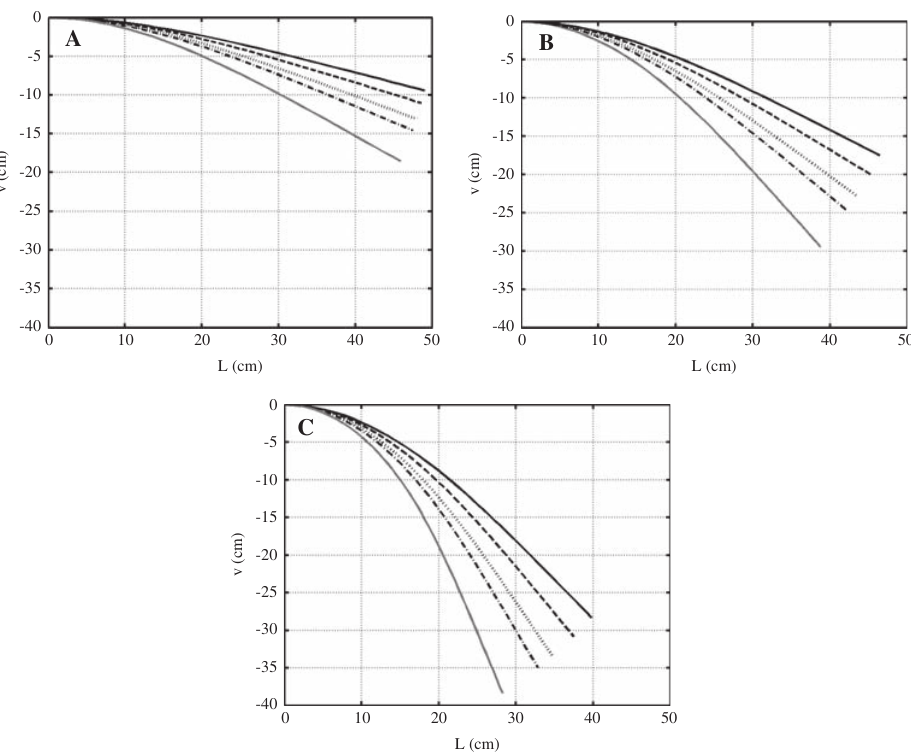
Figure 7 Defl ected shape of the beam for various values of the power-law exponent for (A) q = 125 N/cm 2 , (B) q = 250 N/cm 2 , (C) q = 500 N/cm 2 , ( – – – – ) full ceramic, ( – – – ) k = 0.3, (------) k = 1, ( – – – ) k = 3, ( – – – – ) full metal.